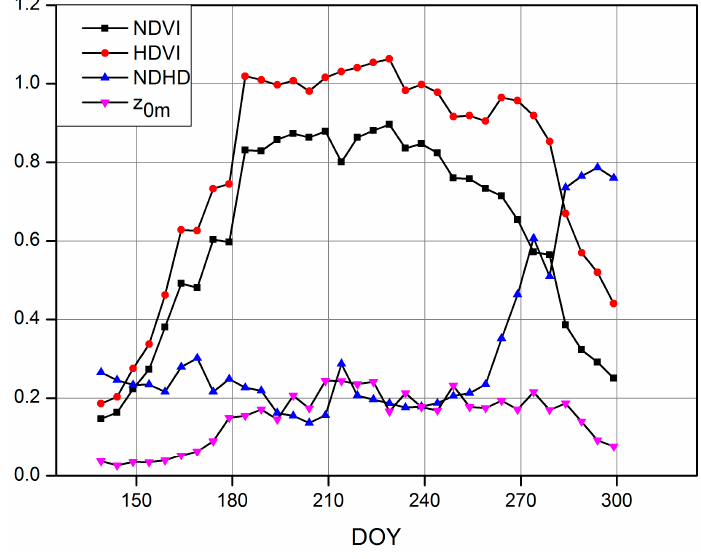
Figure 5. Time series profiles of NDVI, HDVI, NDHD and field observed z 0m during the spring maize growing season at Yingke site in 2014. z 0m is presented as a five-day average, and NDVI is shown as the maximum value over five days. NDHD and HDVI were calculated with Equations (15) and (16), respectively.